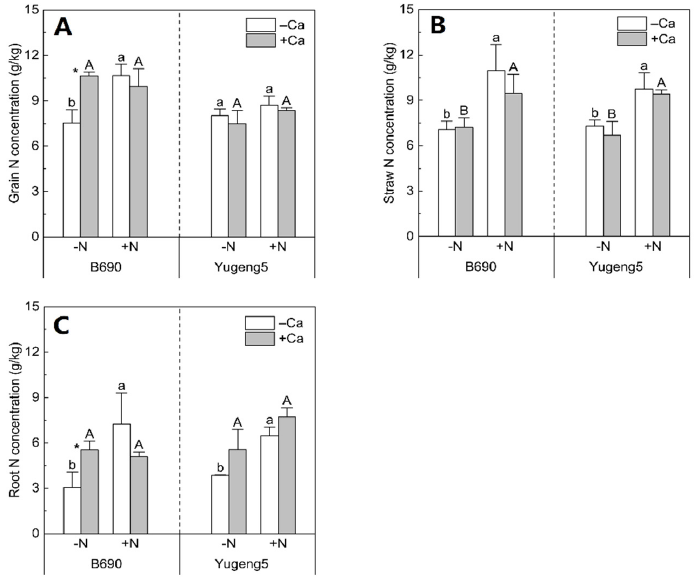
Figure 3. E ff ects of nitrogen (N) and lime on N concentrations in rice cultivars ‘B690’ and ‘Yugeng5’. ( A ), Grain N concentration; ( B ), straw N concentration; ( C ), root N concentration. Two rice cultivars were grown in pots in a greenhouse without ( − N) or with (+N) N fertilizer, in the absence ( − Ca) or presence (+Ca) of lime, till maturity. Different lowercase and capital letters above bars indicate significant differences between − N and +N treatments under − Ca and +Ca conditions for the same rice cultivar, respectively ( p < 0.05, independent-sample t test). Asterisks indicate significant di ff erences between − Ca and +Ca treatments for the same rice cultivar ( p < 0.05, independent-sample t test).